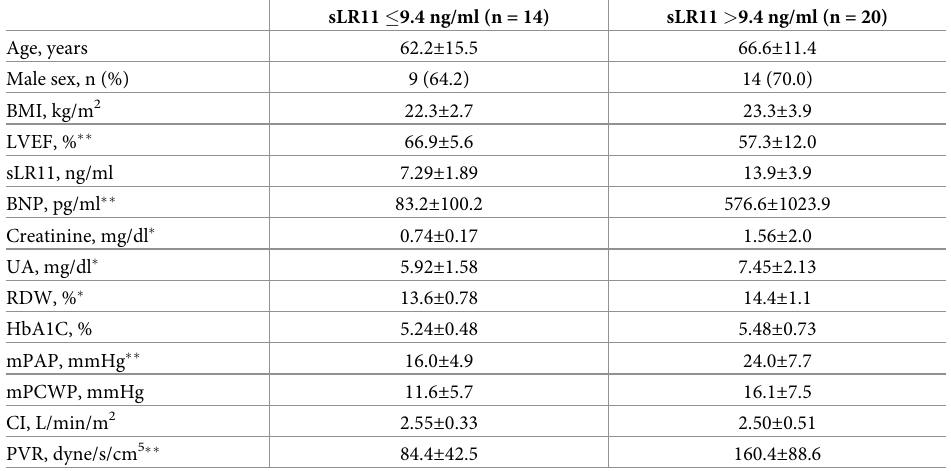
Table 3. Comparison of baseline patient characteristics in normal-sLR11 and high-sLR11 group.